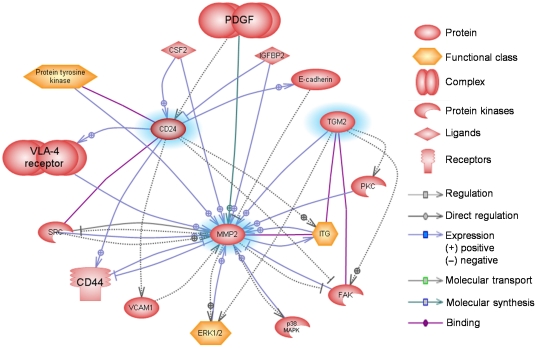
Interacting pathways of transglutaminase 2 (TGM-2), matrix metalloproteinase 2 (MMP-2), and CD24 in pterygium.Selected entities were analyzed with interacting TGM-2, MMP-2, and CD24 pathways by using Ariadne Pathway Studio 6.0.